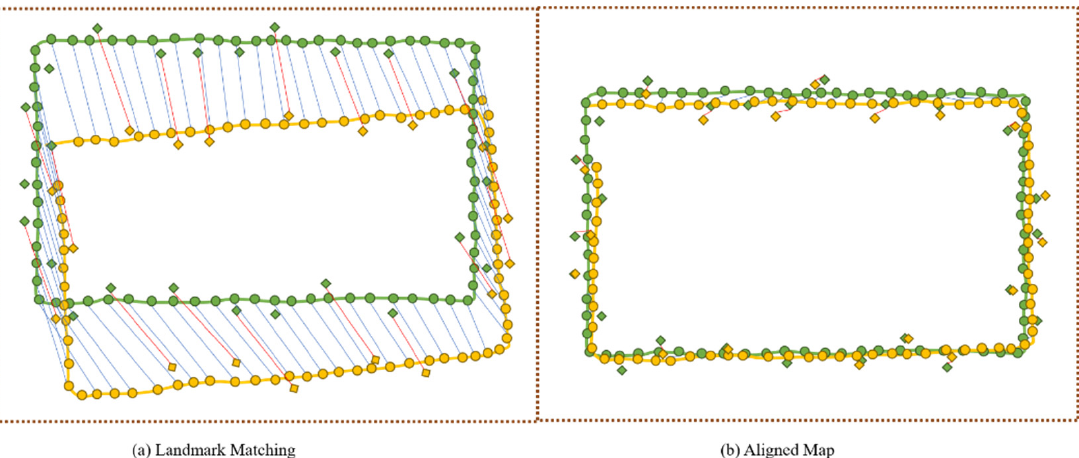
Figure 3. The schematic diagram of map alignment. ( a ) The process of landmark matching, and ( b ) the aligned maps after transformation.